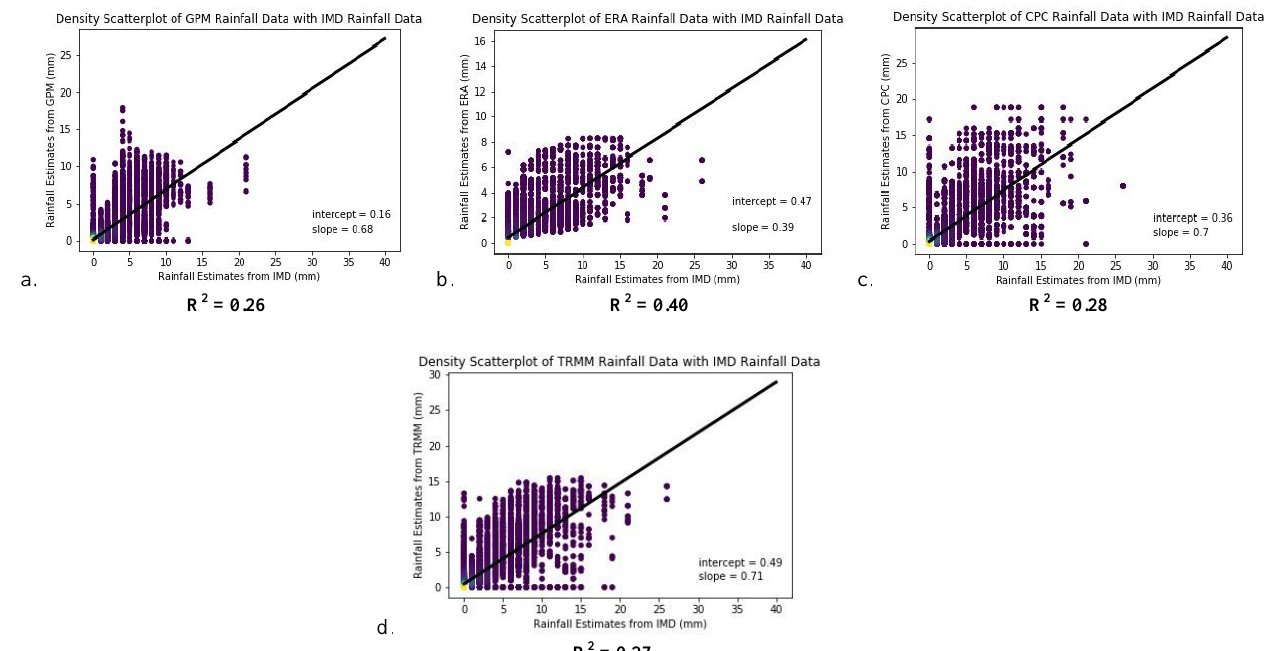
Figure 6: Scatter plots of daily precipitation products with observational rainfall product (with average R 2 values)